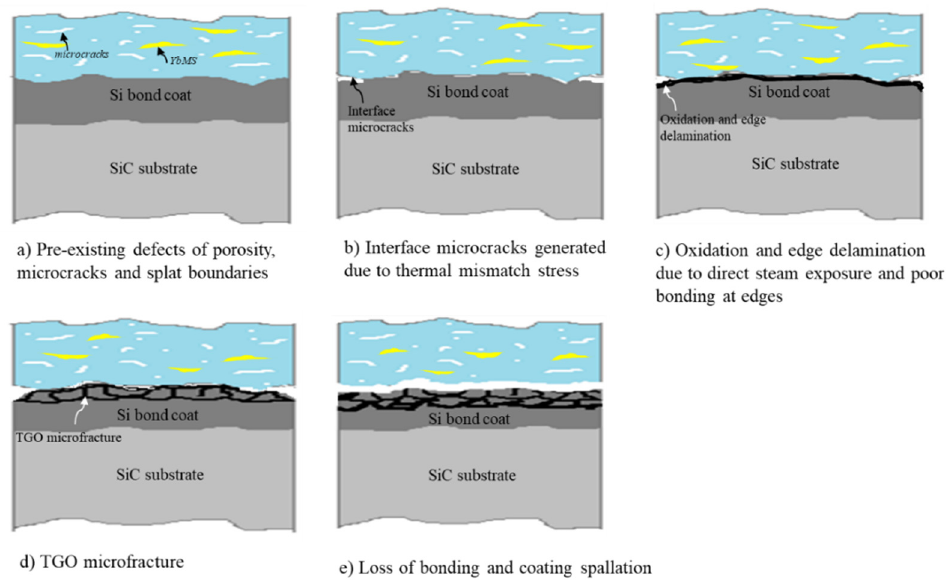
Figure 11. Schematic of damage evolution of APS EBCs in a steam cycling test. ( a ) Pre-existing defects of porosity, microcracks and plant boundaries, ( b ) Interface microcracks generated due to thermal mismatch stress, ( c ) Oxidation and edge delamination due to direct steam exposure and poor bonding at edges, ( d ) TGO microfracture, ( e ) Loss of bonding and coating spallation.